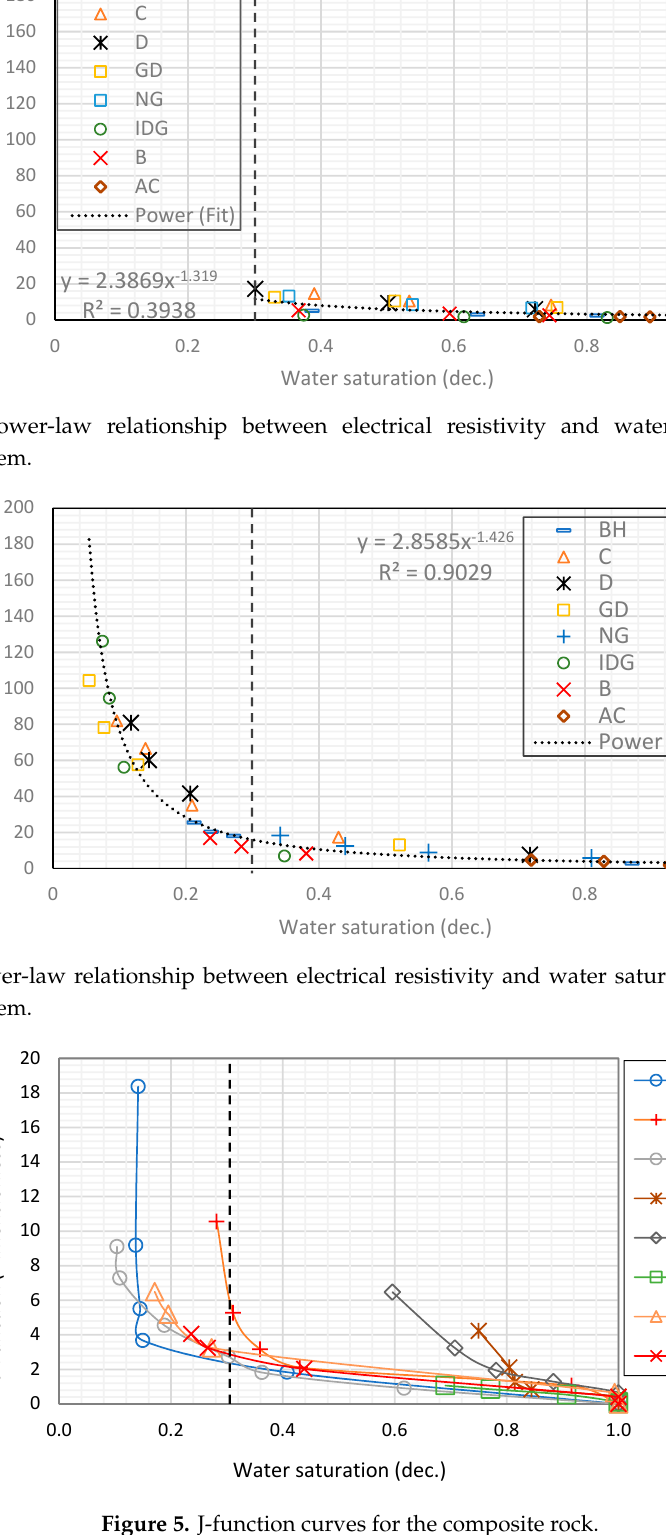
Figure 5. J-function curves for the composite rock.